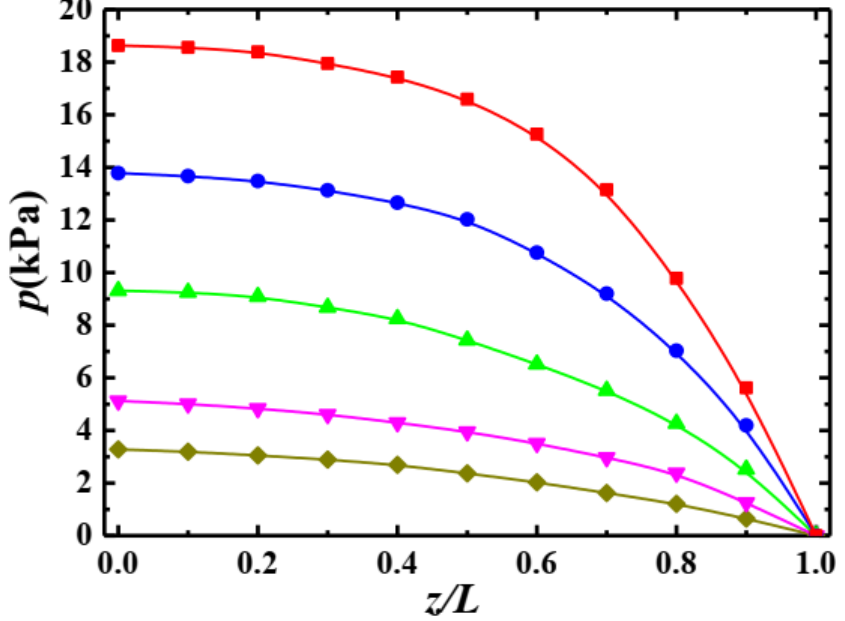
Figure 4. Pressure distributions along the flow direction ( d p = 100 µ m, V = 7 m/s, m s = 15 t/h). (cid:4) : α s = 20%; • : α s = 15%;